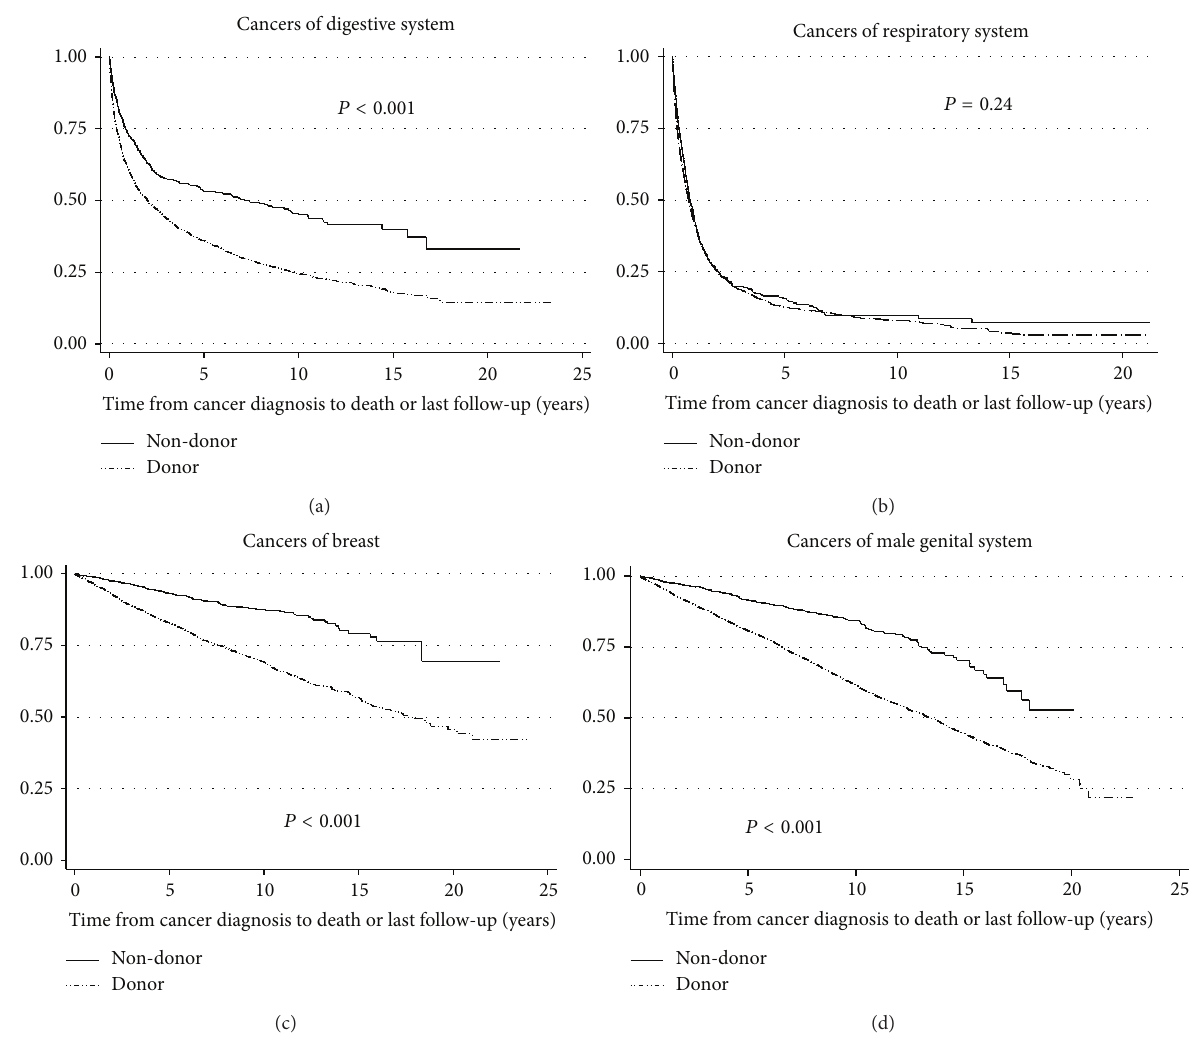
Figure 3: KM survival curves for all-cause mortality for donors and nondonors with (a) cancers of digestive system ( 𝑃 < 0.001 ); (b) cancers of respiratory system ( 𝑃 = 0.24 ); (c) breast cancers ( 𝑃 < 0.001 ); (d) cancers of male genital system ( 𝑃 < 0.001 ); 𝑥 -axis represents survival time in